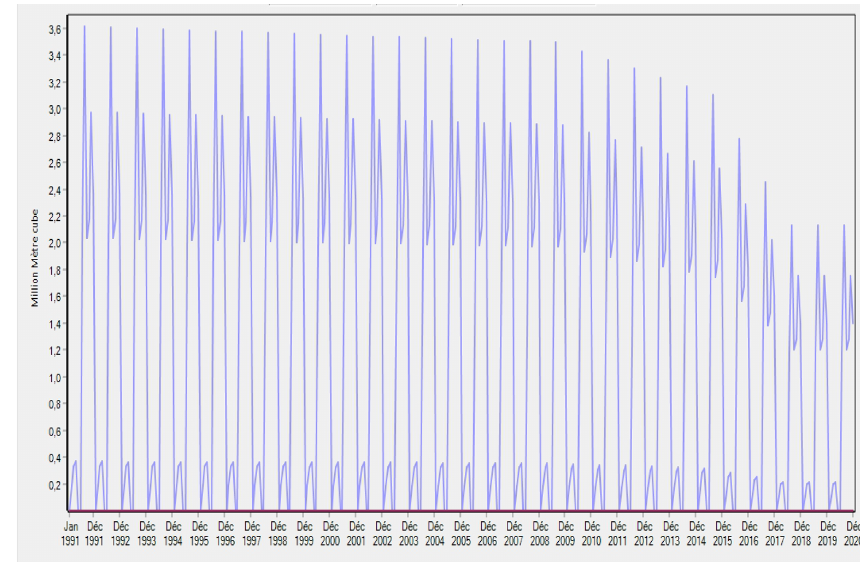
Figure 11. Débit de retour (non utilisée) (Modélisation avec WEAP).